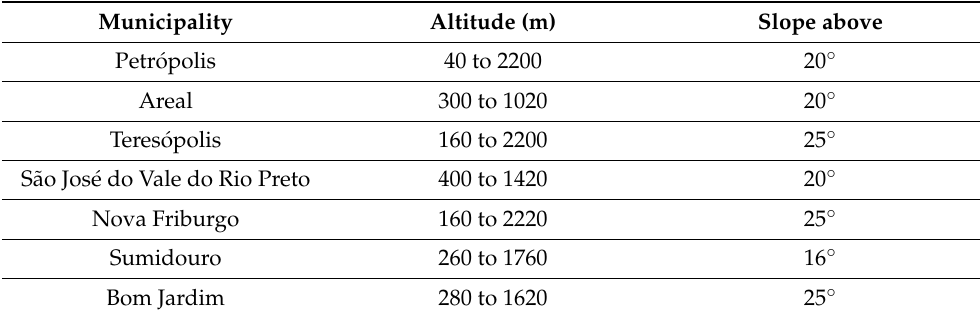
Table 1. Geomorphological characteristics of the municipalities of the mountainous region of Rio de Janeiro State (Figure 1). Municipality Altitude (m) Slope above Petr ó polis 40 to 2200 20 ◦ Areal 300 to 1020 20 ◦ Teres ó polis 160 to 2200 25 ◦ 400 to 1420 20 ◦ Nova Friburgo 160 to 2220 25 ◦ Sumidouro 260 to 1760 16 ◦ 280 to 1620 25